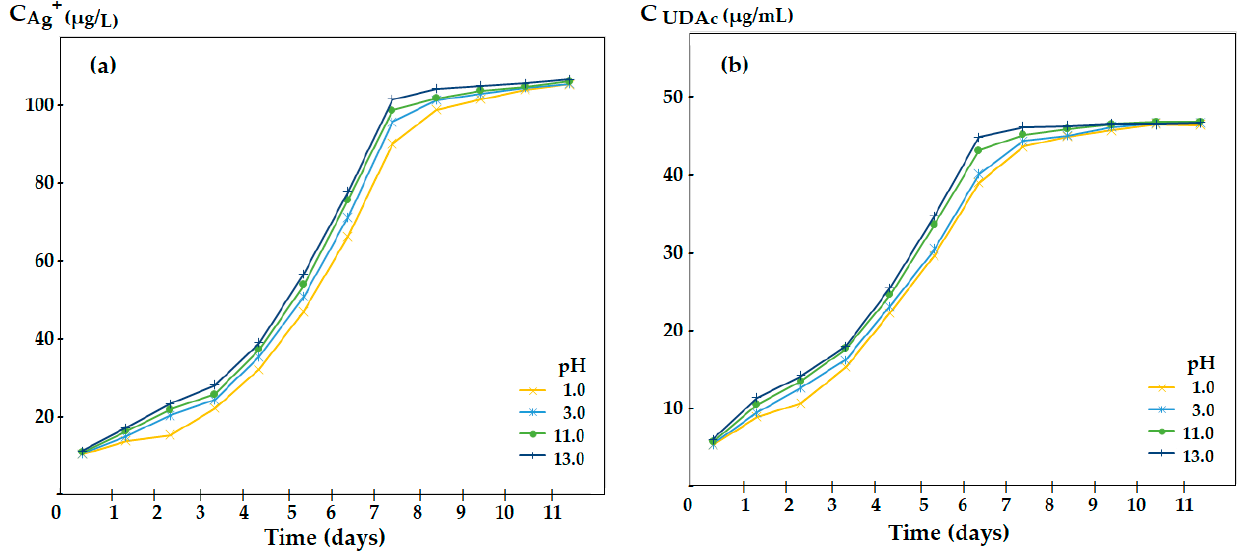
Figure 10. Concentration of silver ions ( a ) and of 10–undecenoic acid ( b ) released in the receiving aqueous phase of variable pH, depending on the type of contact.